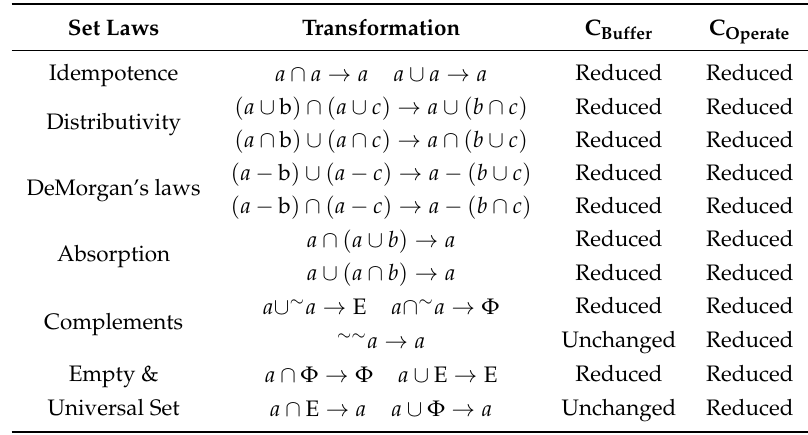
Figure 5. Set operations of overlay analysis in HiBO. Table 5. Expression Simplification of